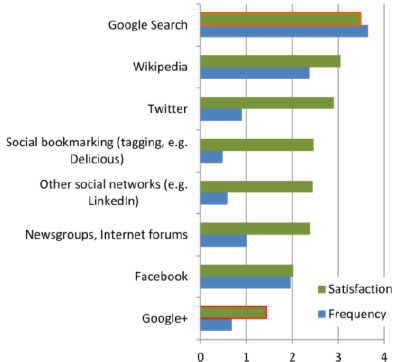
Figure 12. Means of students’ respons es to the